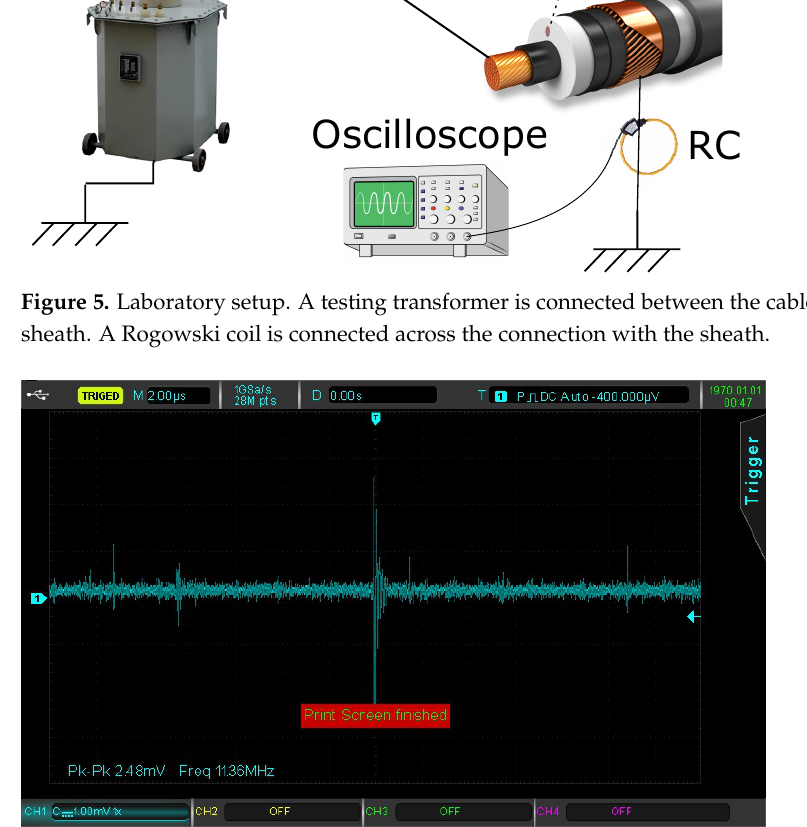
Figure 6. Acquired PD signal from the cable, due to an internal void using a Rogowski coil.